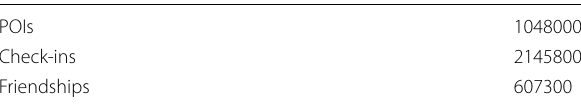
Table 4 Distribution of